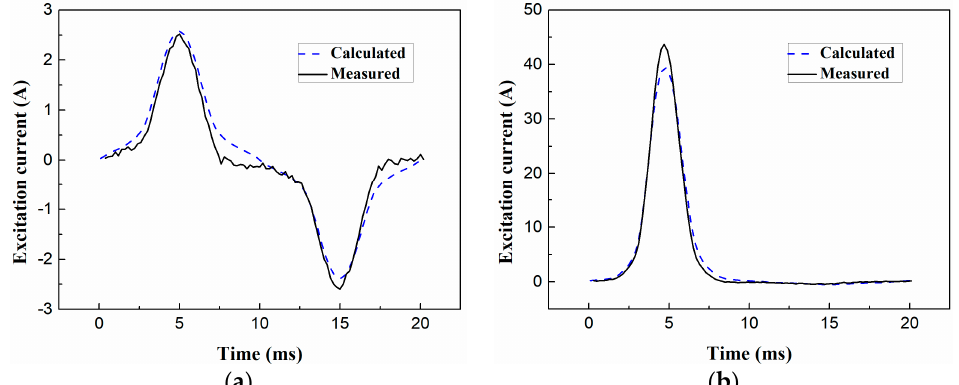
Figure 15. The excitation current of calculated and measured with and without DC bias current. ( a ) without DC bias current. ( b ) with 5 A DC bias current. Appl. Sci. 2020 , 10 , x FOR PEER REVIEW